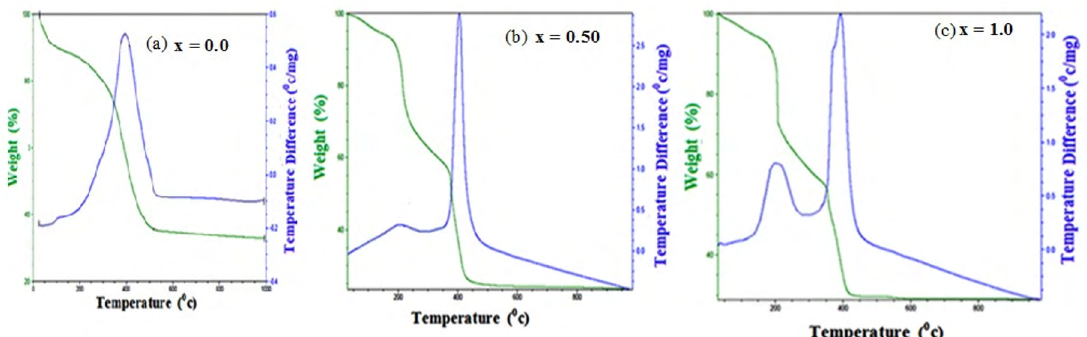
Ni AlCrO (where x = 0.0, 0.50, 1-x x 4